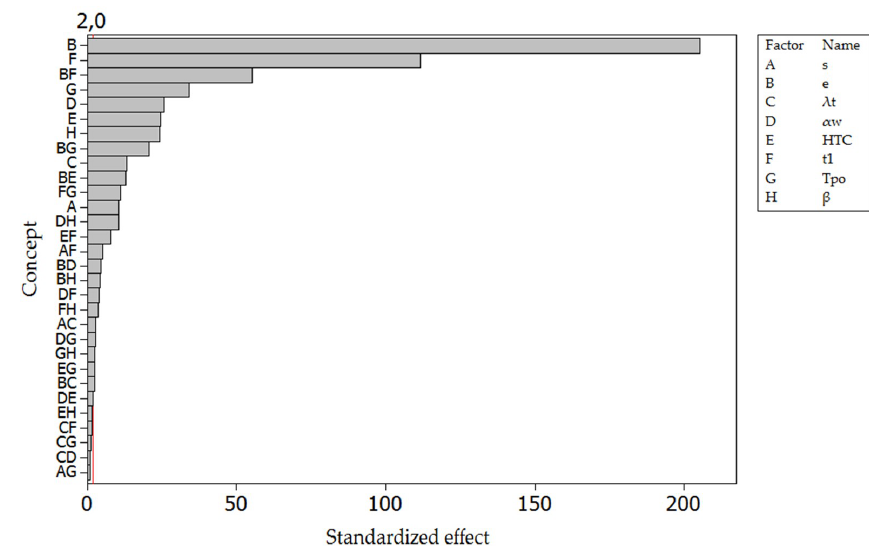
Figure 9. Normal graph of standardized effects.